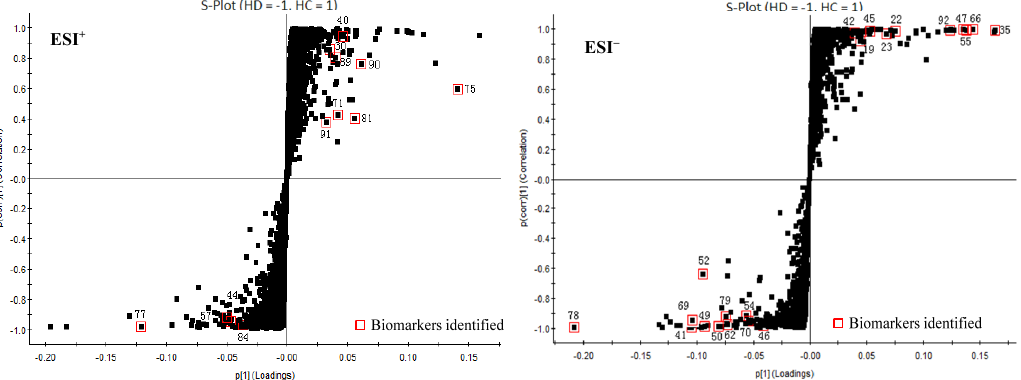
Figure 5. The OPLS-DA/Coefficients vs. VIP of HC and HD in positive (ESI + ) and negative mode (ESI − ).